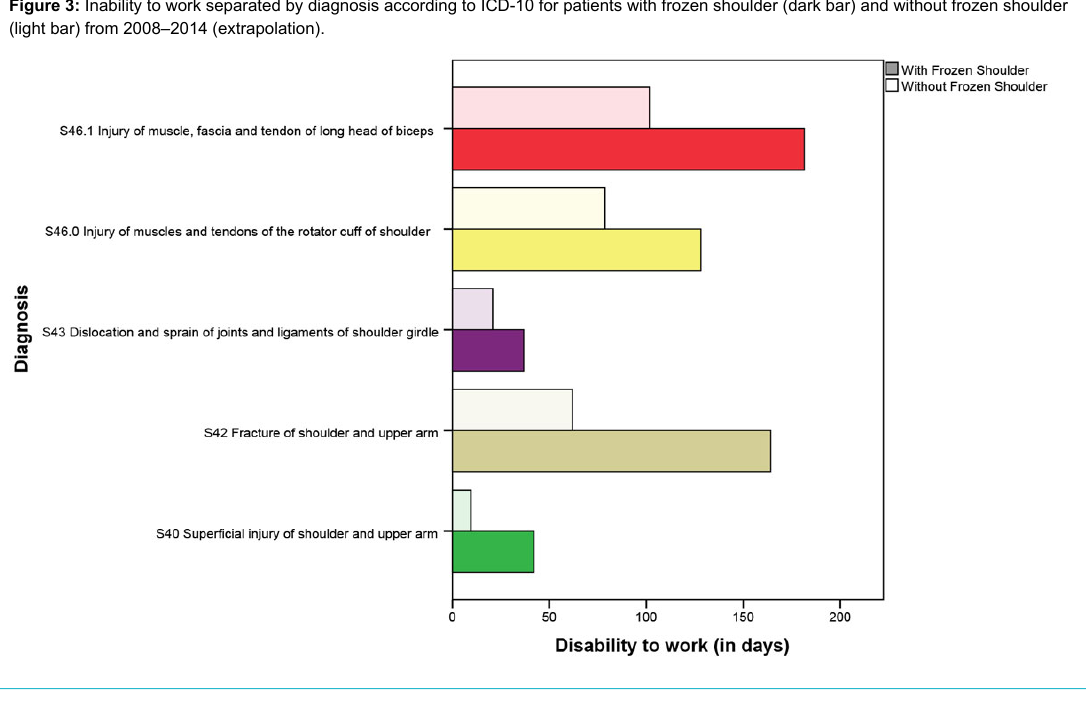
Table 3: Inability to work in percentage for patients with frozen shoulder (FS) and without frozen shoulder (without FS) in long-term cases (>90 days) and very-long-term cases (>360 days) separated by main diagnosis. The factor between the two is the respective odds ratio (OR). Main